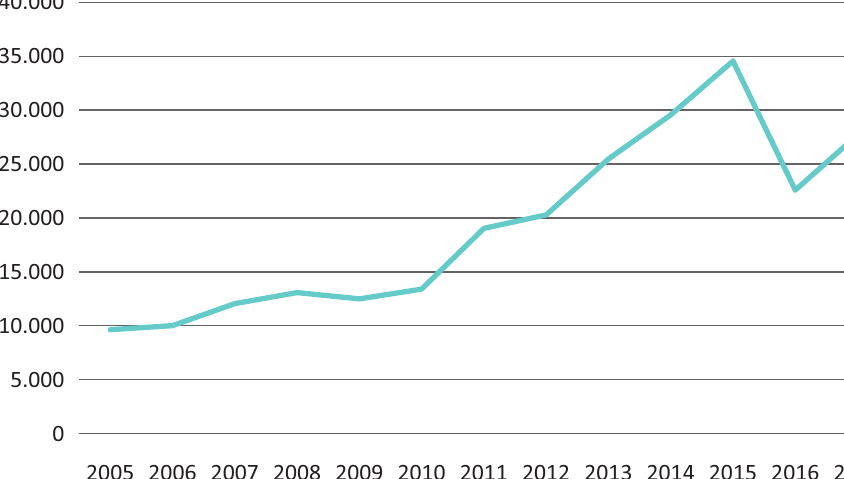
Figure 1. Spanish youth (16–34 years old) emigration during the period 2005–2017. Compiled by the authors based on data from the Residential Variation Statistics of the National Statistics Institute of Spain (INE,